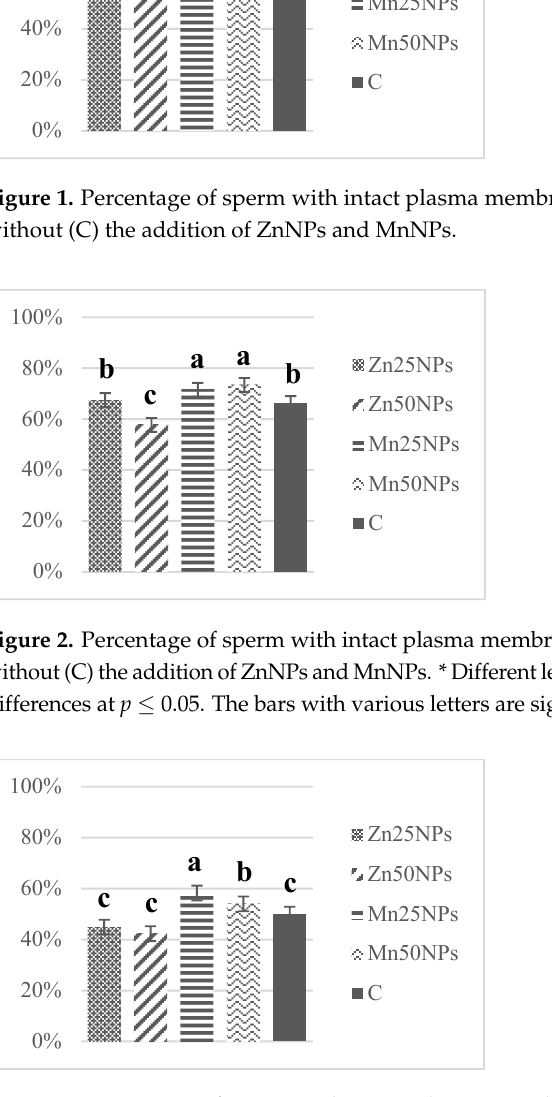
Figure 3. Percentage of sperm with intact plasma membrane (%) in samples stored for 48 h with or without (C) the addition of ZnNPs and MnNPs. * Different letters (a, b, c) indicate statistically significant differences at p ≤ 0.05. The bars with various letters are significantly different from one another.